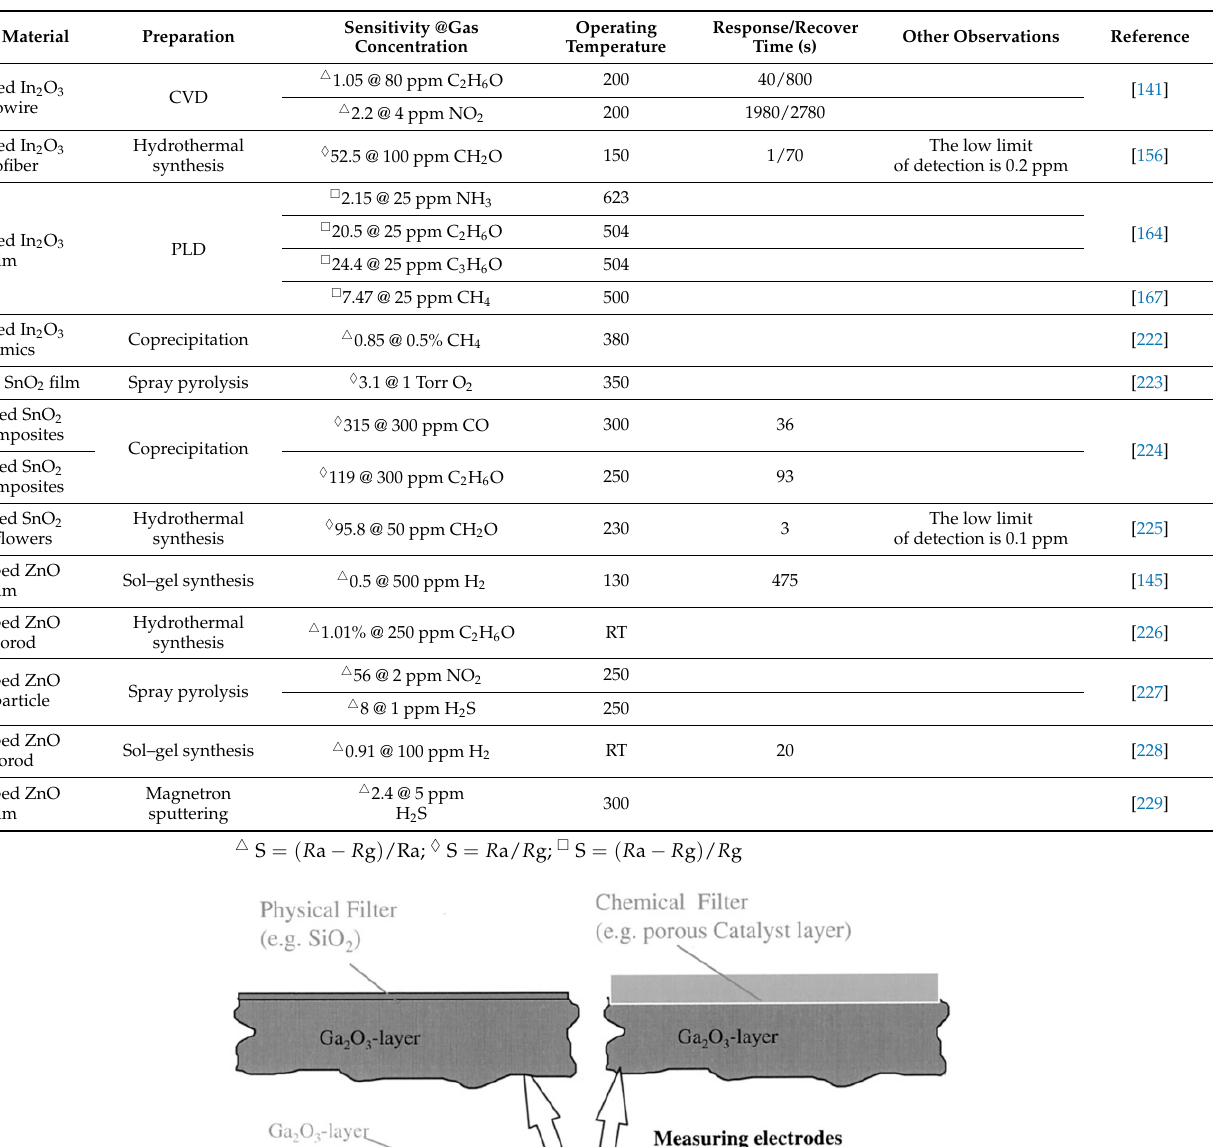
Table 4. Enhanced sensing performances of gas sensors using Ga-contained metal oxides.